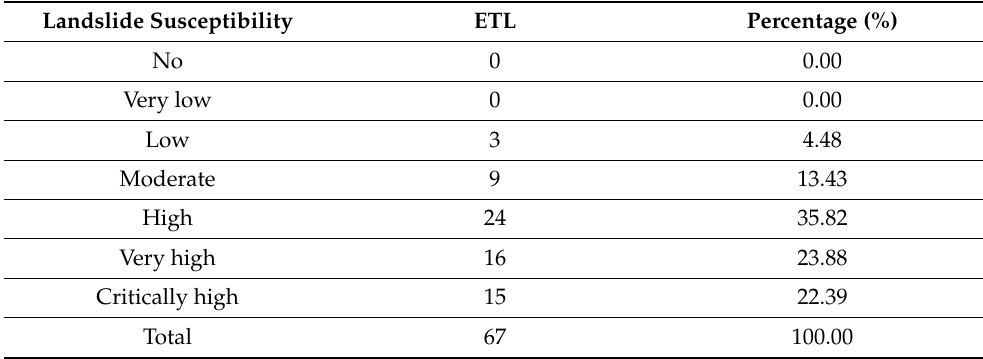
Table 7. Distribution of the recorded historical and recent ETL in the detected landslide susceptibility zones of Cephalonia